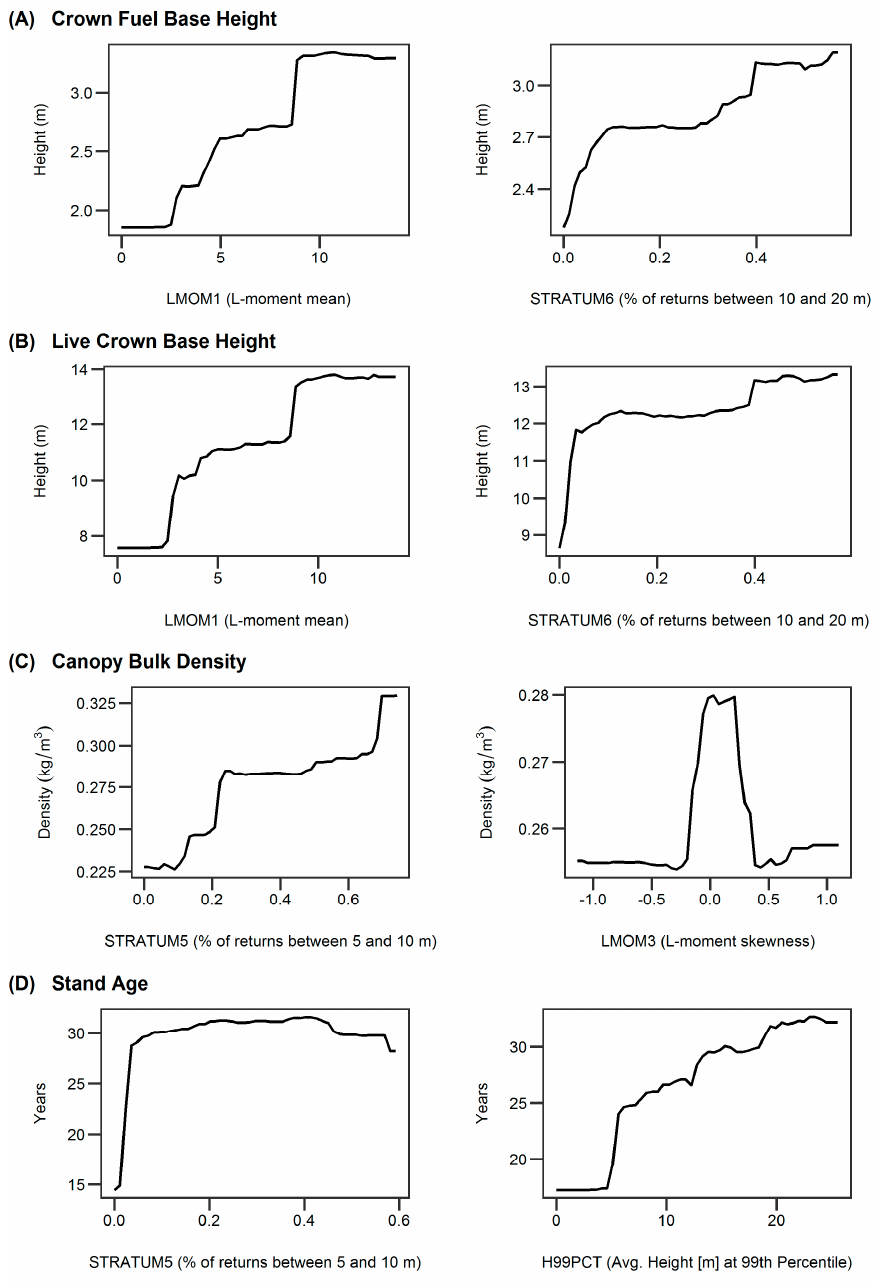
Figure 5. Partial dependence plots describing the marginal effects of the top two predictors from randomForest models of ( A ) crown fuel base height, ( B ) live crown base height, ( C ) canopy bulk density, and ( D ) stand age.